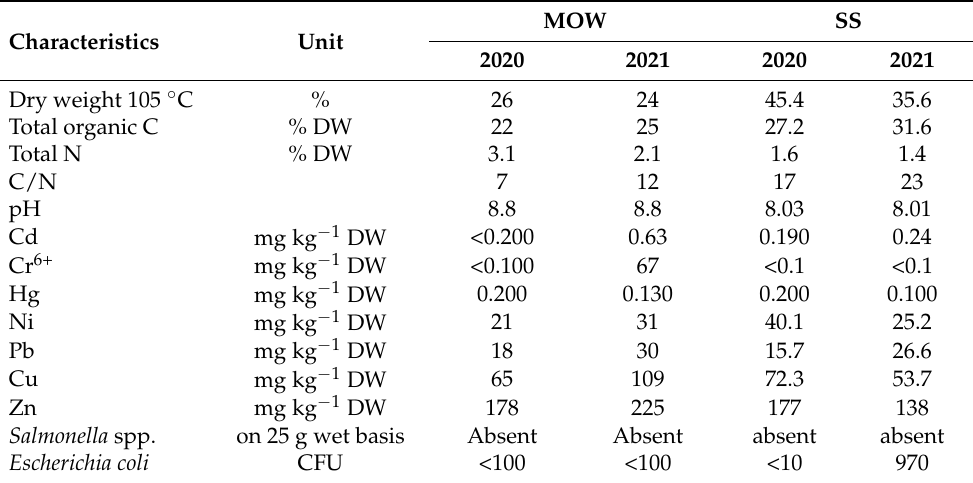
Table 2. Main chemical and physical characteristics of the amendments used in the experiment in 2020 and 2021.